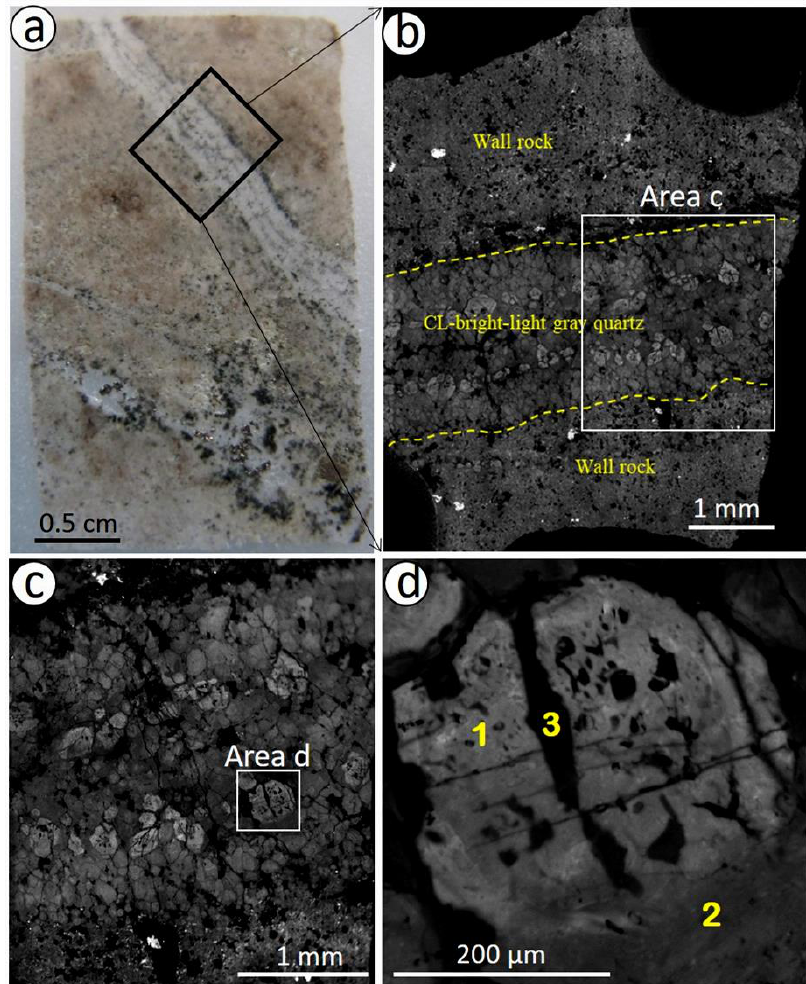
Figure 9. ( a ) Doubly polished thin section of INT#1 (sample KD-3a). ( b ) SEM-CL image of early quartz vein cutting potassic alteration. ( c ) SEM-CL image clearly shows multiple generations of quartz with CL-bright and CL-gray quartz. ( d ) At least three generations of quartz formation (1 to 3) are identified as CL- bright, CL-gray (dissolution qtz), and CL-dark, which is the last generation.